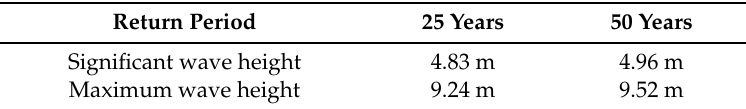
Figure 8. Predicted maximum wave height for different return periods. Table 1. Return values for the significant wave height and maximum wave height for the Lysekil test site.